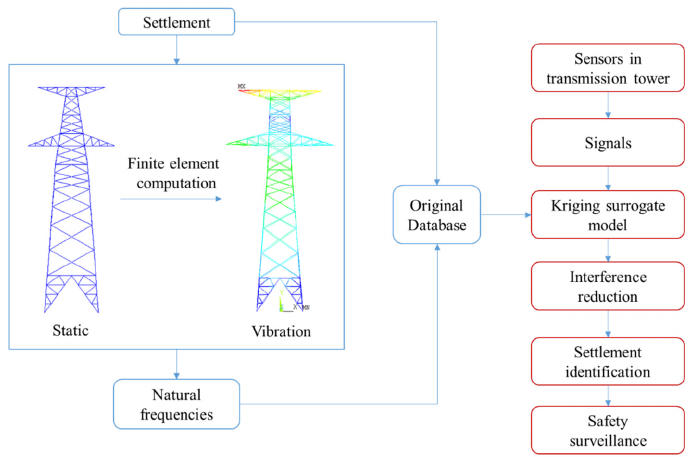
Figure 2. Schematic diagram of interference reduction in the settlement surveillance sensor. Appl. Sci. 2019 , 9 , x FOR PEER REVIEW